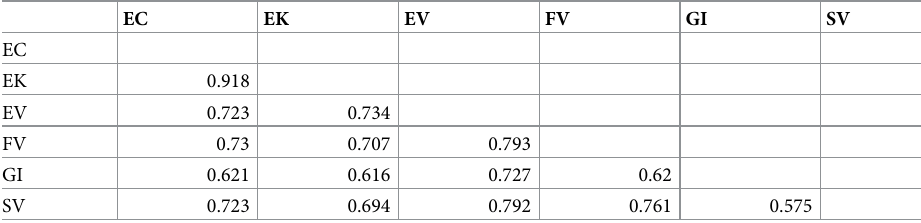
Table 5. Heterotrait-Monotrait Ratio (HTMT).